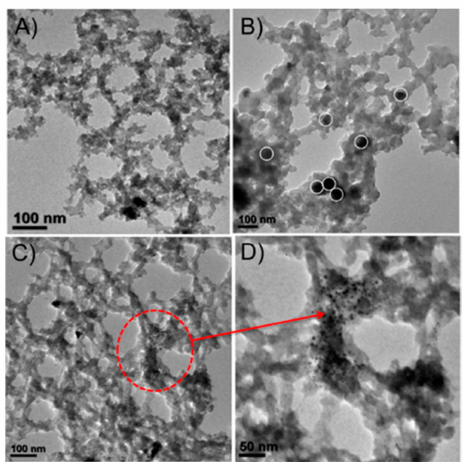
Figure 4. ( A – D ) TEM images of metal-nanoparticle-encapsulated POPs. ( D ) is the magnified portion of ( C ). Reproduced with permission from [52]. Copyright 2015, Springer Nature.